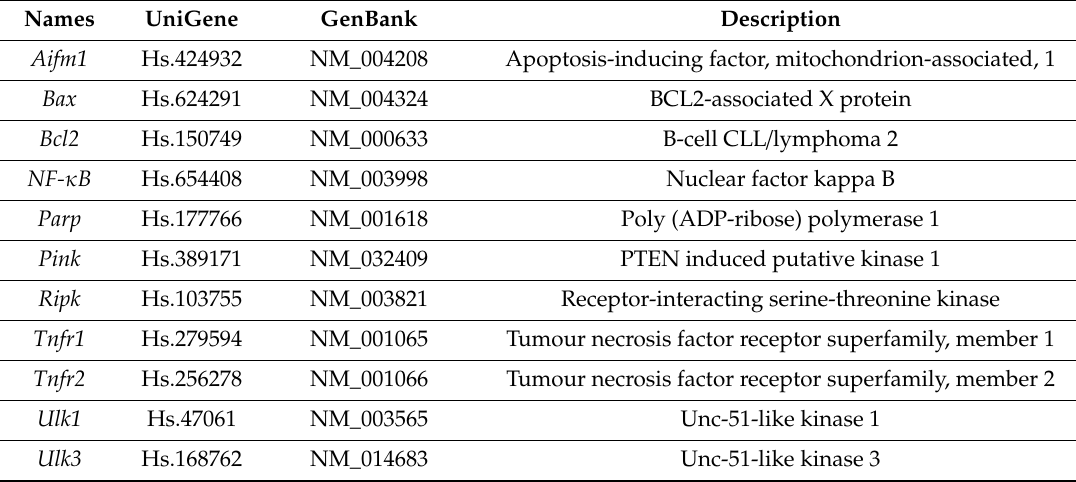
Table 4. List of human genes with accession numbers in UniGene and GenBank (from https: // geneglobe. qiagen.com / product-groups / rt2-profiler-pcr-arrays), and short description of encoded proteins.